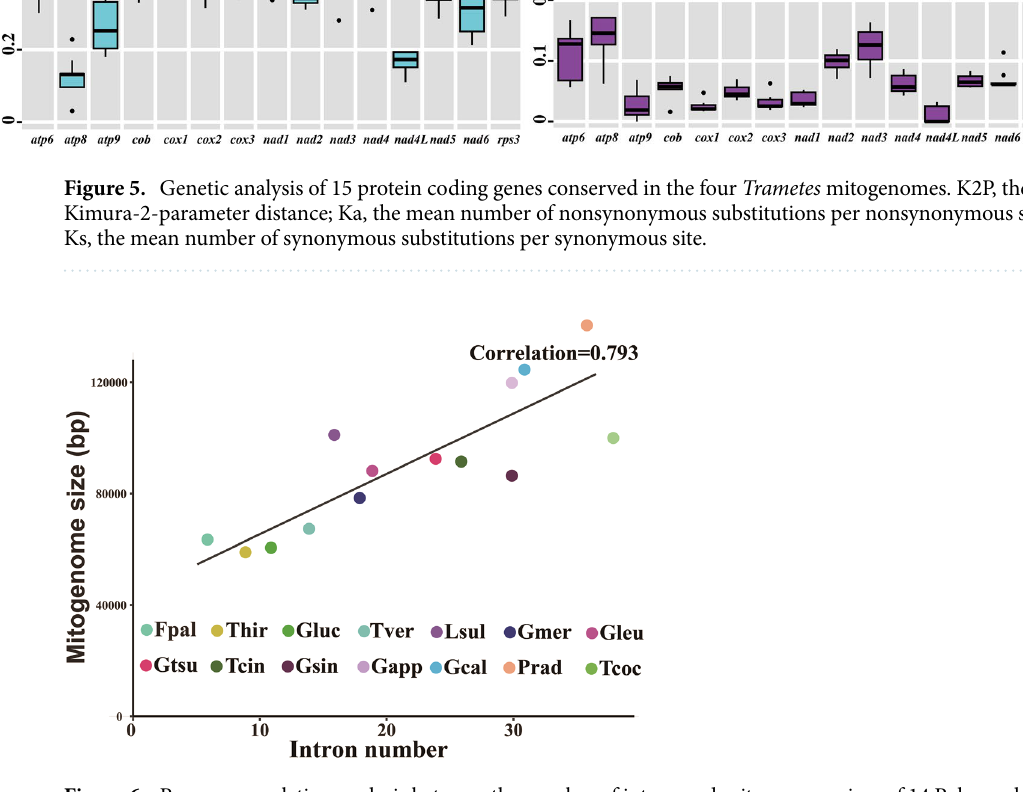
Figure 6. Pearson correlation analysis between the number of intron and mitogenome sizes of 14 Polyporales species. Species and NCBI accession numbers for genomes used in the phylogenetic analysis are provided in Supplementary Table